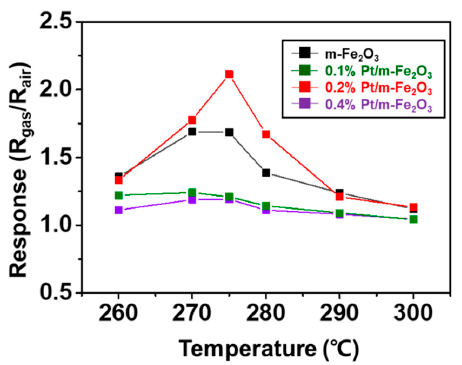
Figure 3. Response of m-Fe 2 O 3 and Pt/m-Fe 2 O 3 (0.1, 0.2, and 0.4 wt% Pt) operating temperature in the range 260 − 300 °C for 100 ppb HCHO gas.